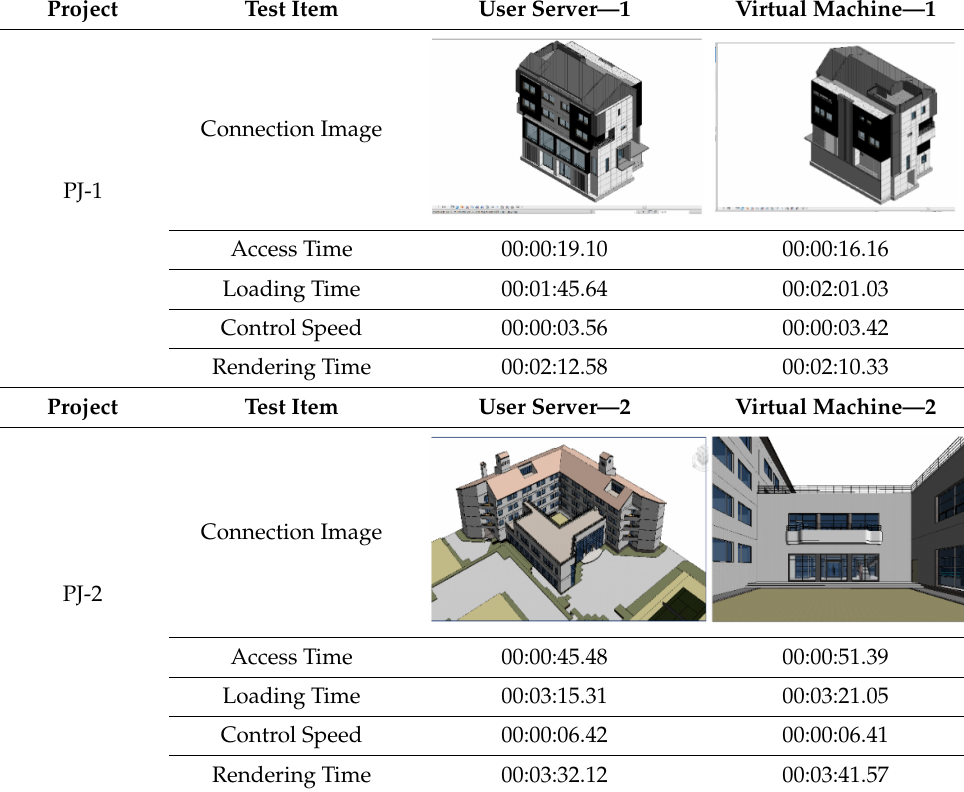
Table 16. Processing time standard personal computer and virtual machine (for Revit)—Project 1, 2.